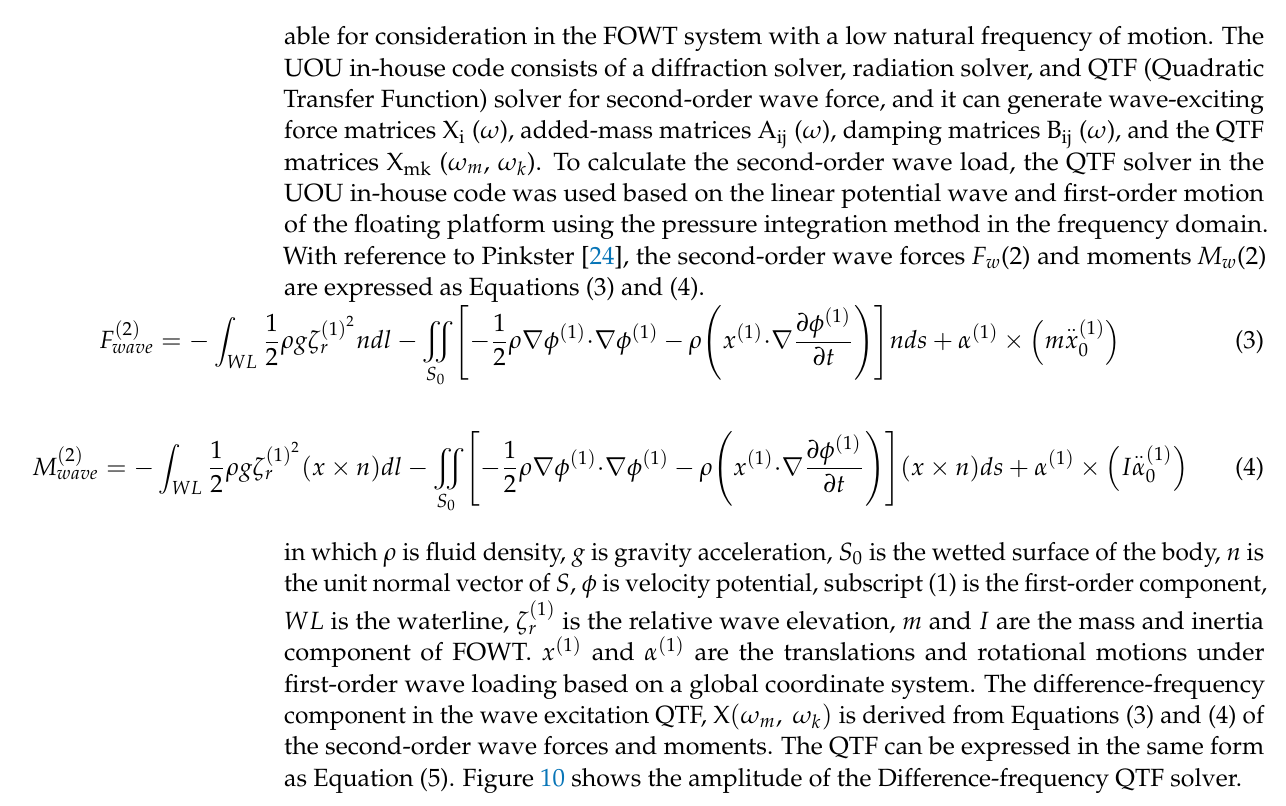
Figure 7. LC1 Regular wave7 Time-series response.